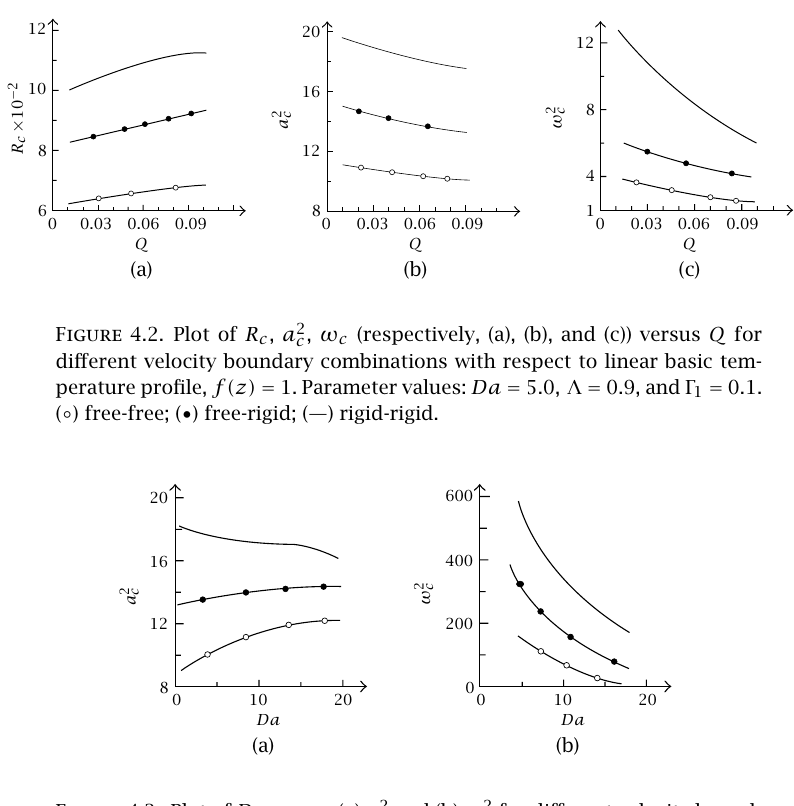
Figure 4.3 . Plot of Da versus (a) a 2 c and (b) ω 2 c for different velocity bound- ary combinations with respect to linear basic temperature profile, f(z) = 1. Parameter values: Λ = 0 . 9 , Q = 0 . 1, and Γ 1 = 0 . 1. ( ◦ ) free-free; ( • ) free-rigid; (—)